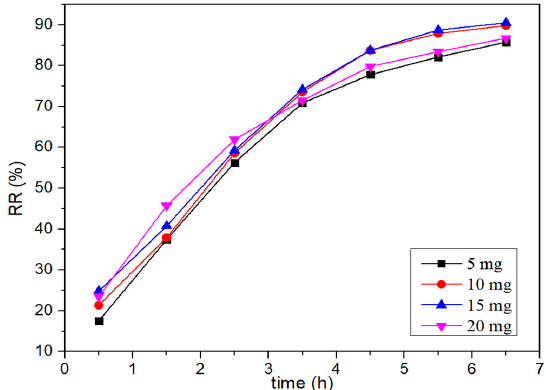
Figure 6. E ff ect of catalyst amounts on the removal rate of tetracycline. Reaction conditions: 20 mg / L tetracycline solution 40 mL, dark reaction 0.5 h, light reaction 6